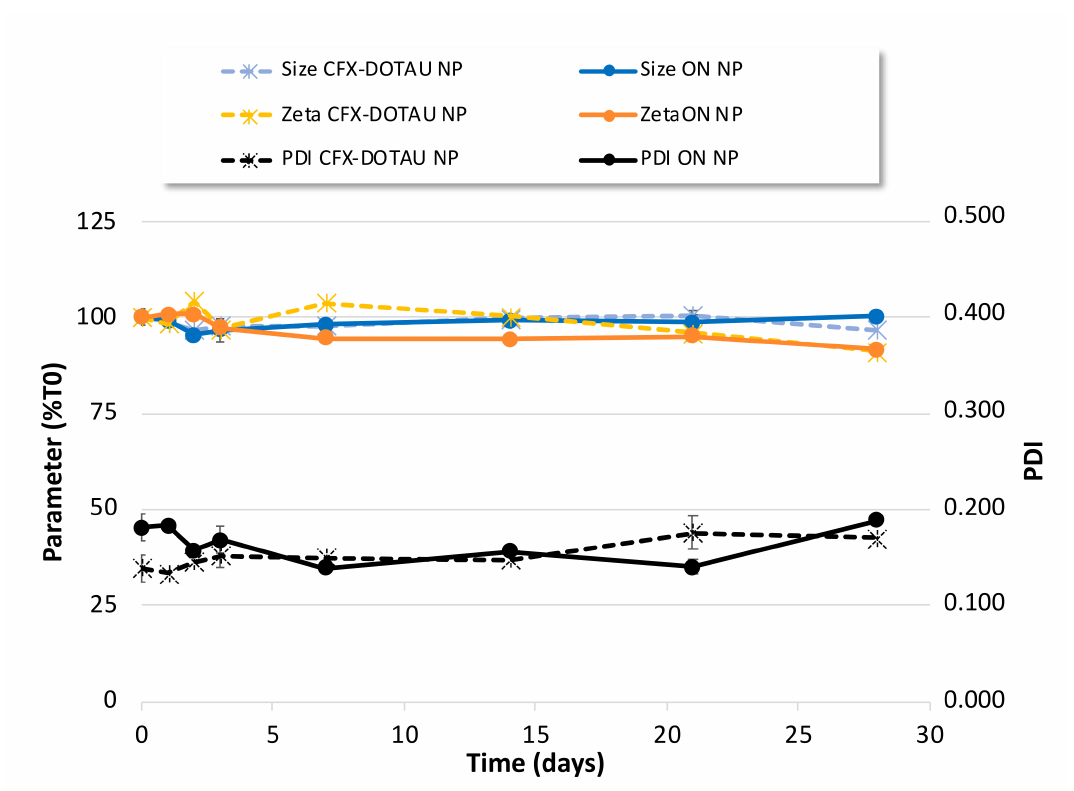
Figure 7. Colloidal stability of CFX–DOTAU and ON α 600 NP characteristics (mean +/ − SD): (left axis, expressed as % T0) size, zeta potential and (right axis)